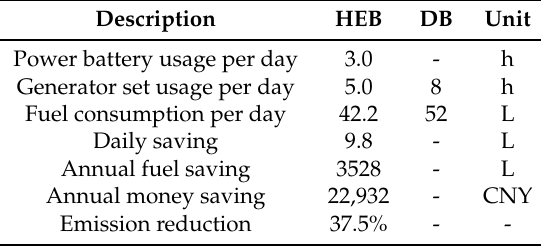
Table 8. Comparison of power consumption of HEB and DB in constant-speed